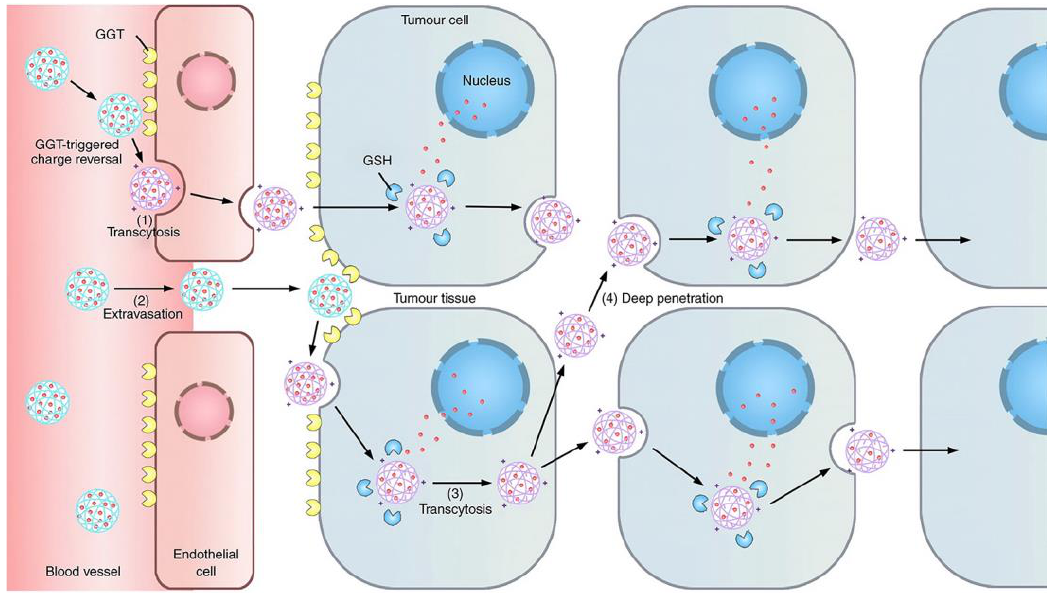
Figure 2. Scheme of the GGT-activatable nanosystem for active tumor penetration through cationization-triggered